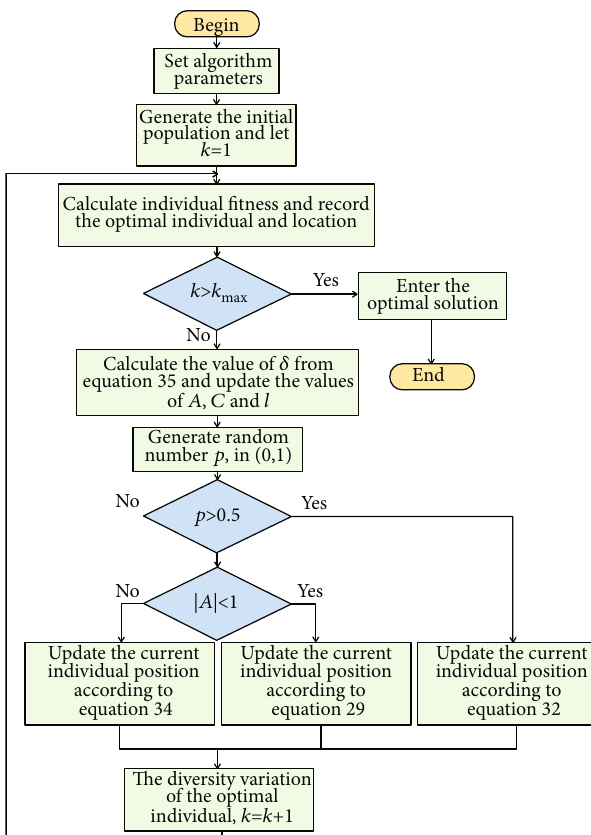
Figure 4: Improved WOA fl ow